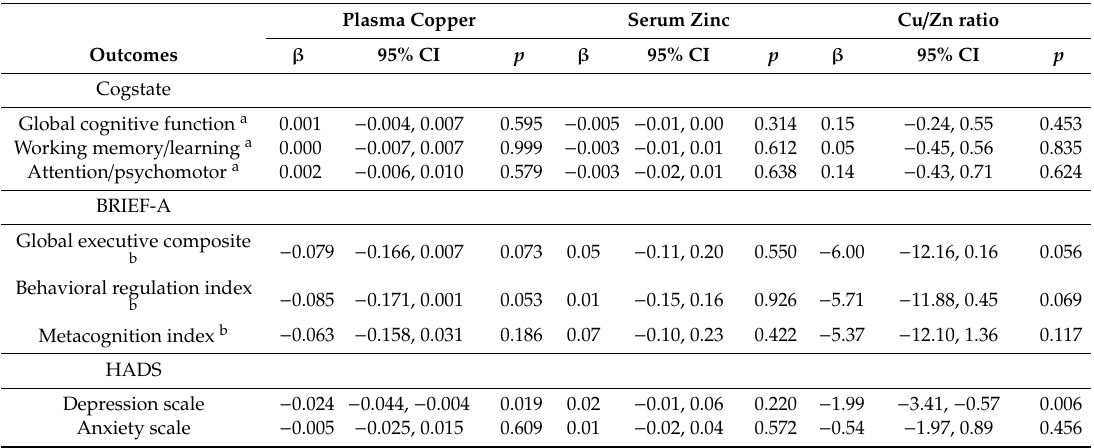
Table 2. Associations between plasma copper, serum zinc, and Cu / Zn ratio and cognitive outcomes and HADS scales in older adults ( n = 139).